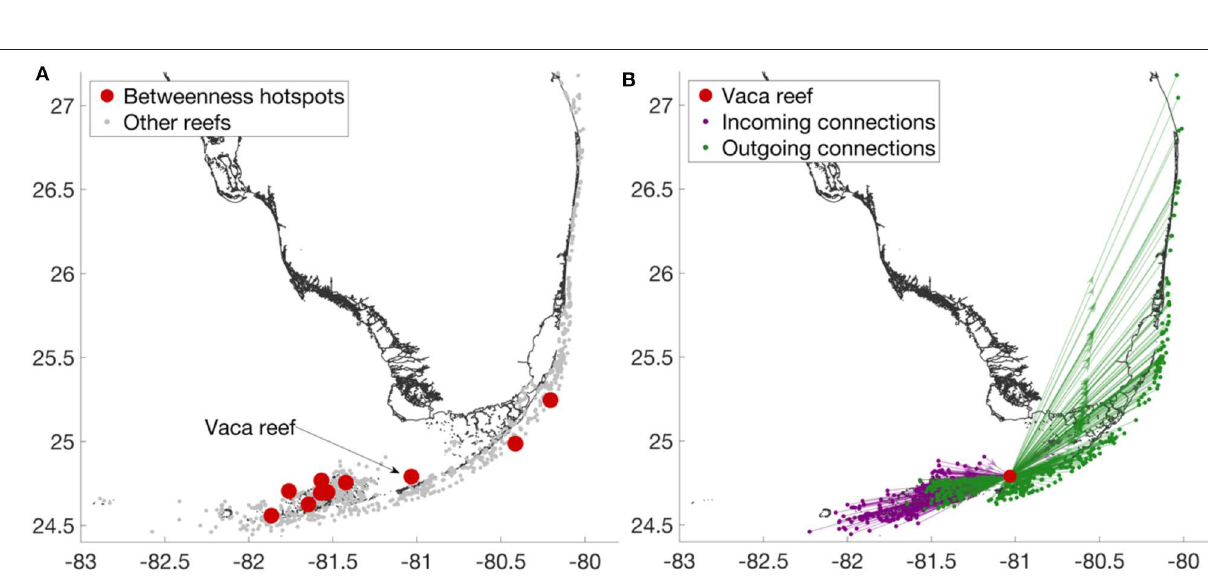
FIGURE 7 | (A) The top 1% reefs with the largest betweenness value. Among these hotspots, the reef with the largest betweenness value is the Vaca reef. (B) Close-up view on the subgraph associated with the Vaca reef. This subgraph highlights the importance of the Vaca reef as a major hub in the connectivity graph. About 2/3 of all the reefs in the FRT are connected to the Vaca